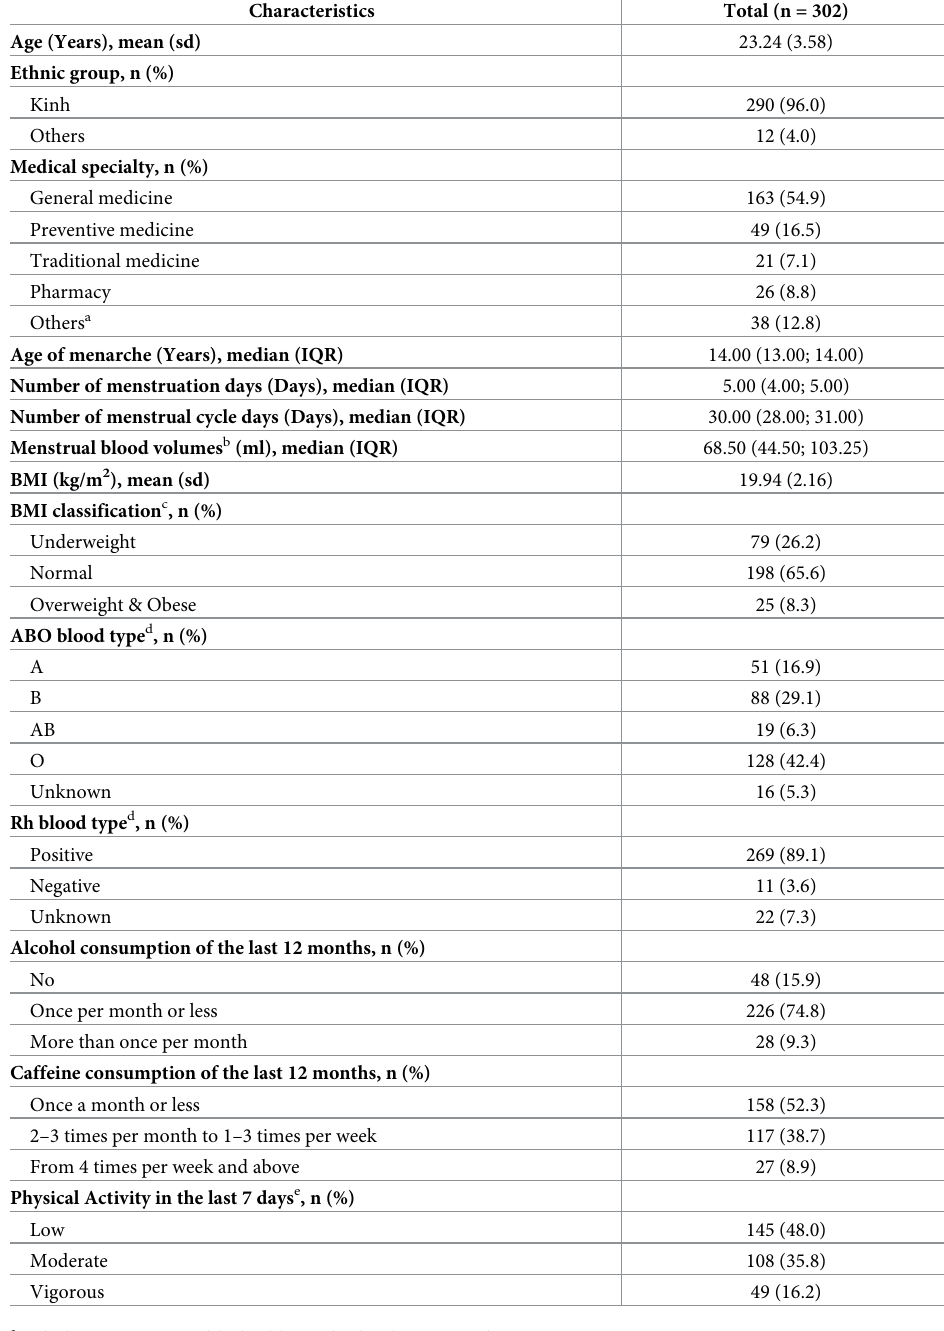
Table 1. Baseline characteristics of study